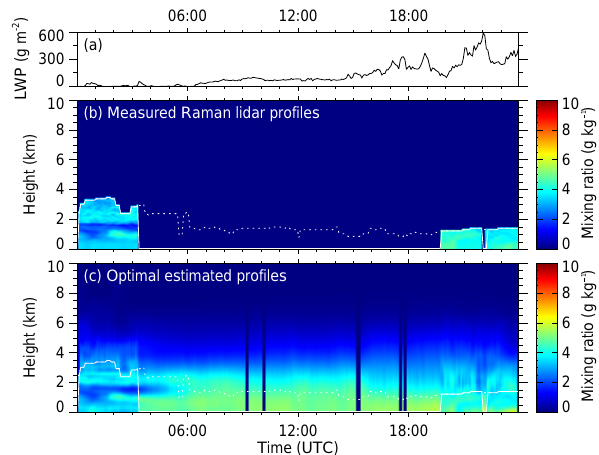
Figure 11. As Fig. 7 but on 21 April